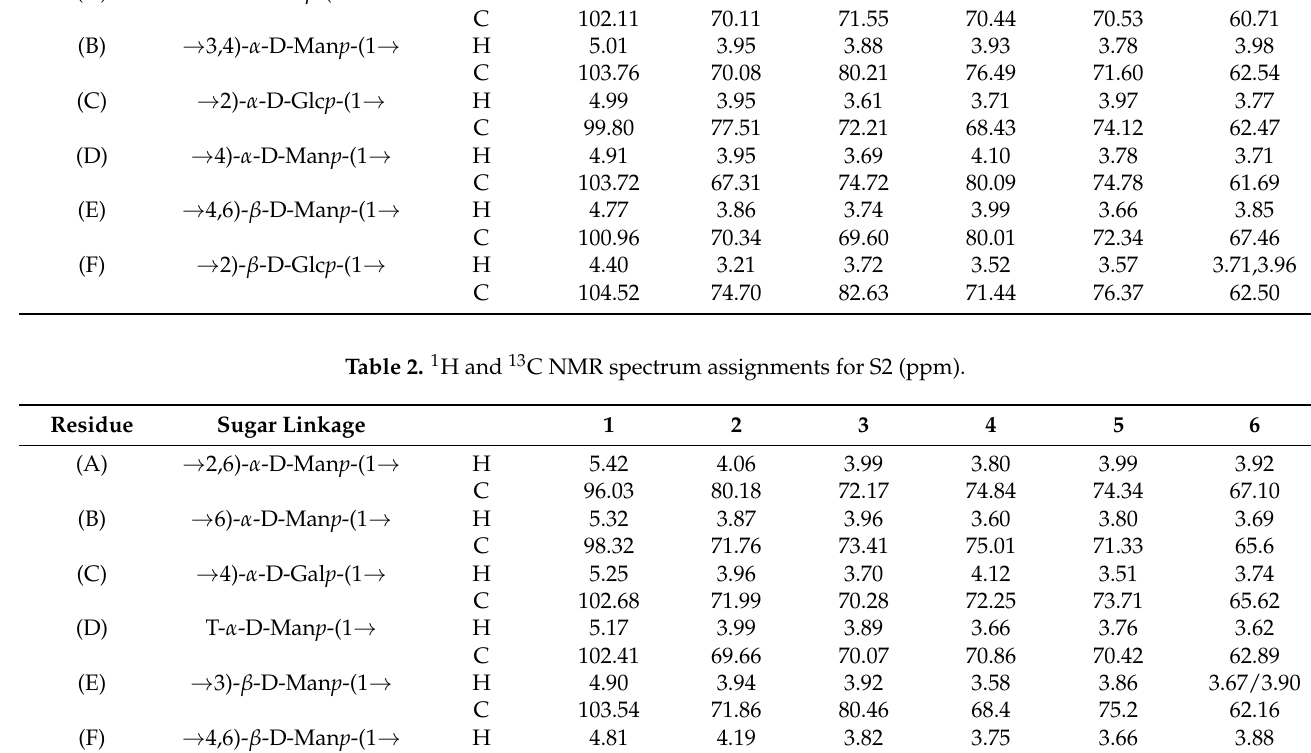
Table 1. 1 H and 13 C NMR spectrum assignments for S1 (ppm).